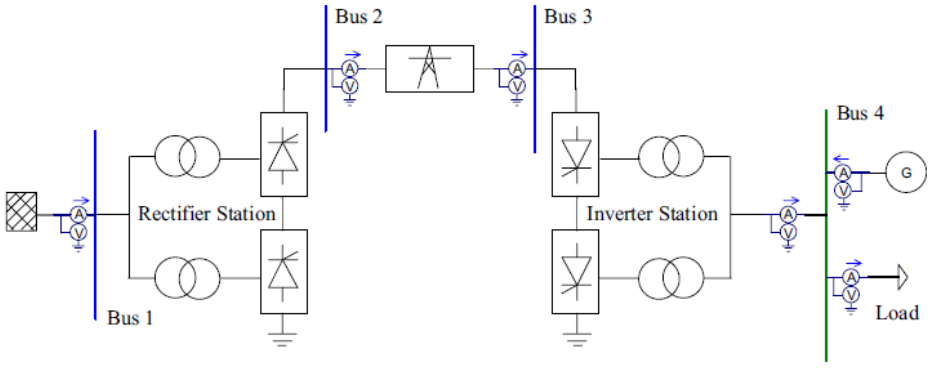
Figure 2. HVDC Transmission Network.